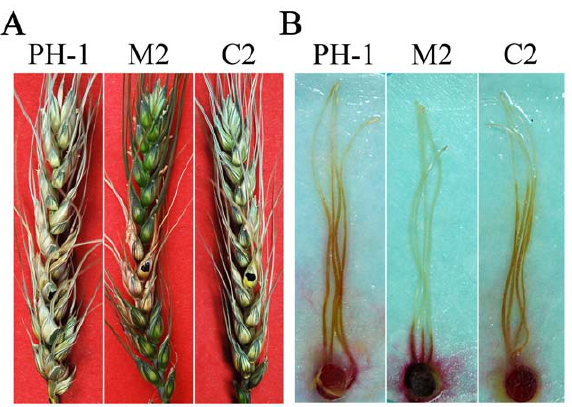
Figure 2. Infection assays with flowering wheat heads and corn silks. A. Flowering wheat heads were drop-inoculated with conidia from the wild-type (PH-1), D amt1 mutant (M2), and D amt1/AMT1 (C2) strains. Black dots mark the inoculated spikeletes. Photographs were taken 14 days post-inoculation (dpi). B. Corn silks were inoculated with blocks of cultures of PH-1, D amt1 mutant M2, and D